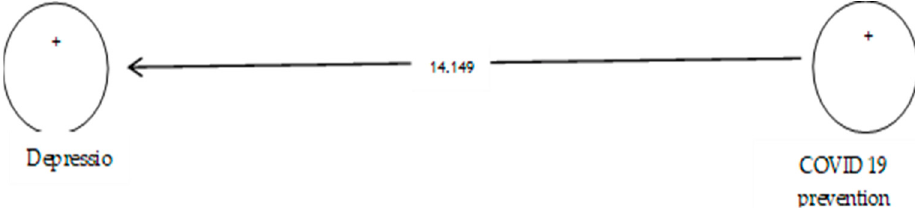
Figure 11. Drawn model with significant coefficients z.